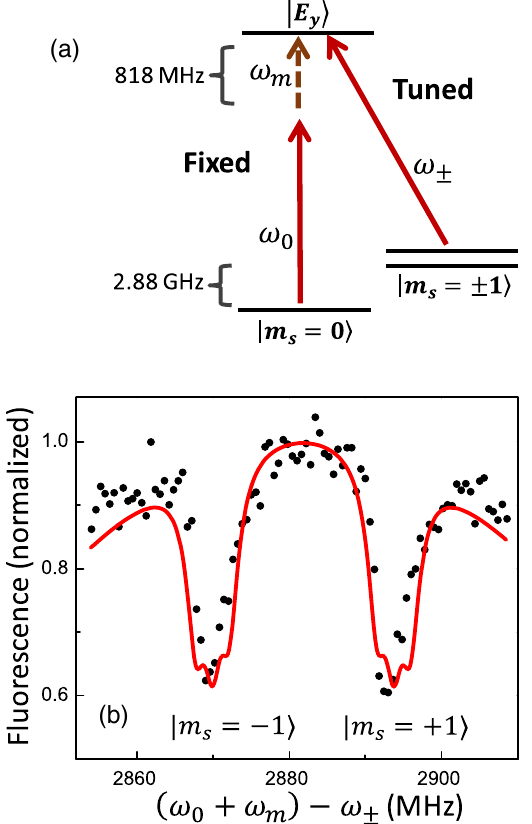
FIG. 4. (a) Energy-level diagram used for phonon-assisted CPT . Solid red arrows are the optical fields. The dashed brown arrow is the acoustic field. (b) Fluorescence from state E as a y − ω ω function of ω 0 þ ω (cid:2) . The optical power at frequency 0 m and ω (cid:2) is 4 μ W and 1 μ W, respectively. The rf input power for the IDT is 0.13 W. The two dips correspond to Λ -type systems ¼ þ 1 or the m ¼ − 1 state. The solid formed with either the m s s red curve is the theoretical calculation discussed in the text. The fluorescence is normalized to the peak of the theoretical ex- citation spectrum with no CPT